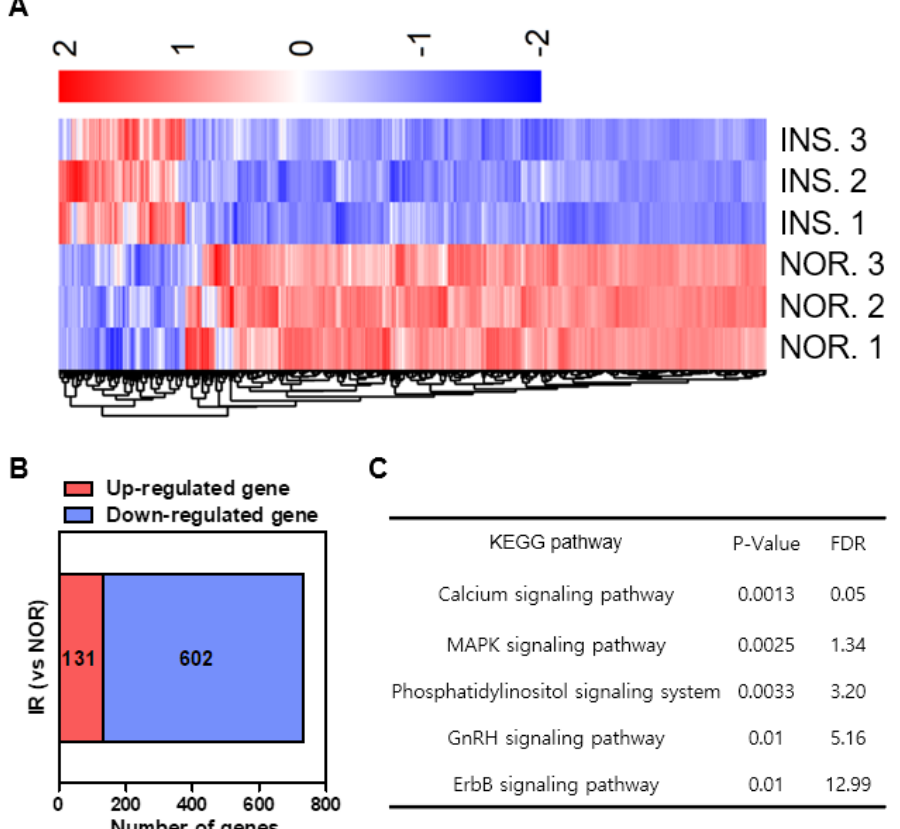
Figure 9. Differential gene expression induced by insulin-treated group (INS) compared to normal group (NOR). ( A ) Heat map based on RNA-sequencing analysis of the gene expression in zebrafish. ( B ) RNA-sequencing for the excess insulin treatment-regulated gene set. ( C ) KEGG pathways.